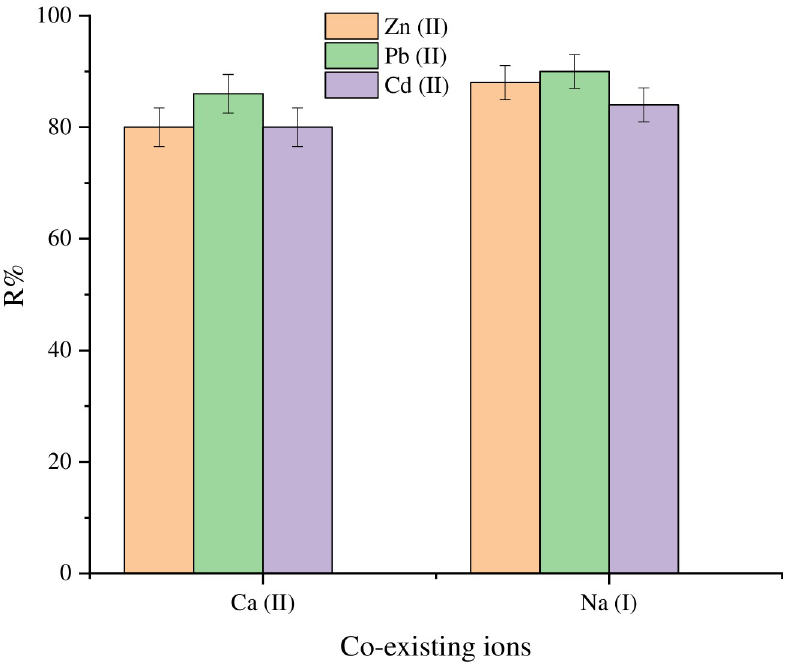
Fig 14. Coexisting Na + and Ca 2+ affect Zn +2 , Pb +2 , and Cd +2 uptake by SnCaAl 2 O 3